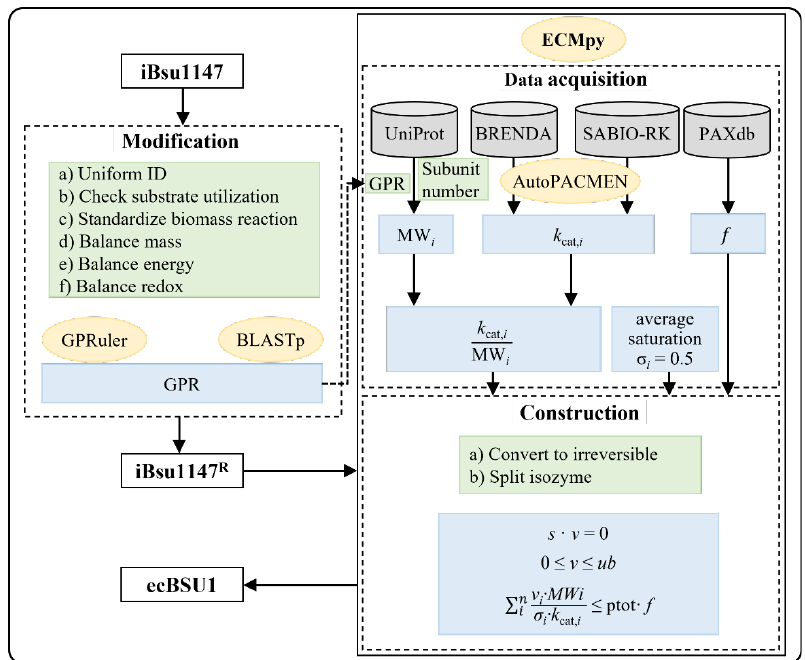
Figure 1. Workflow for the construction of